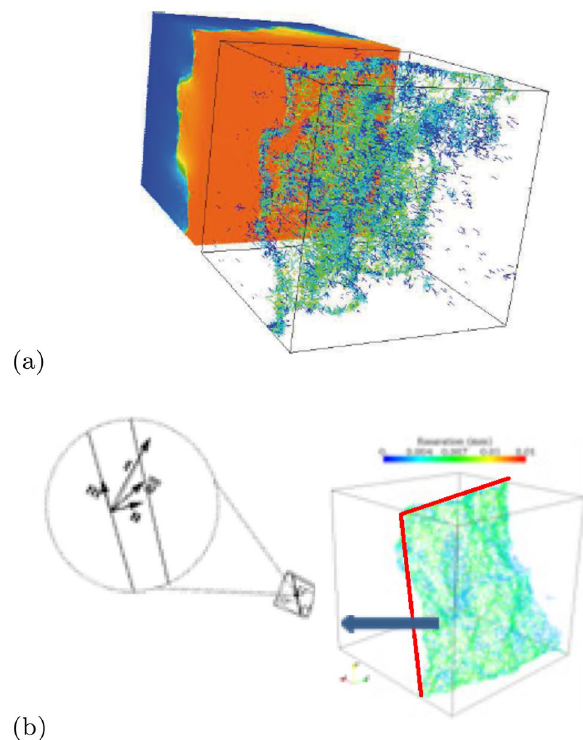
Fig. 15 a Computed failure mode at meso-scale in simple tension test—illustrated with displacement contours and cohesive link failure; b reduced model at macro-scale with ED-FEM for tension failure mode with meso-scale (rough) surface replaced with a dis- continuity (smooth) plane, not matching the crack but rather the fracture energy material parameter G f , t